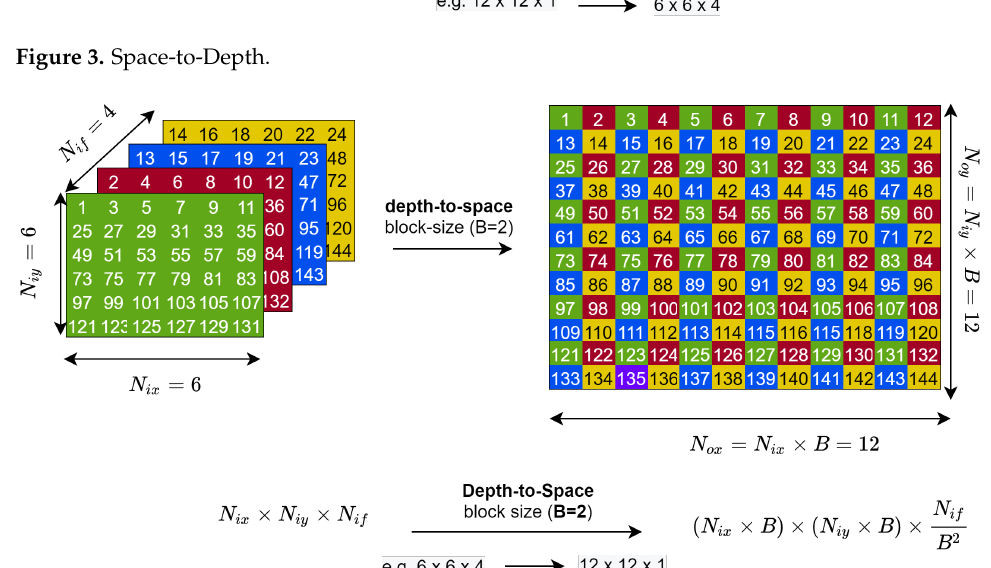
Figure 3. Space-to-Depth.